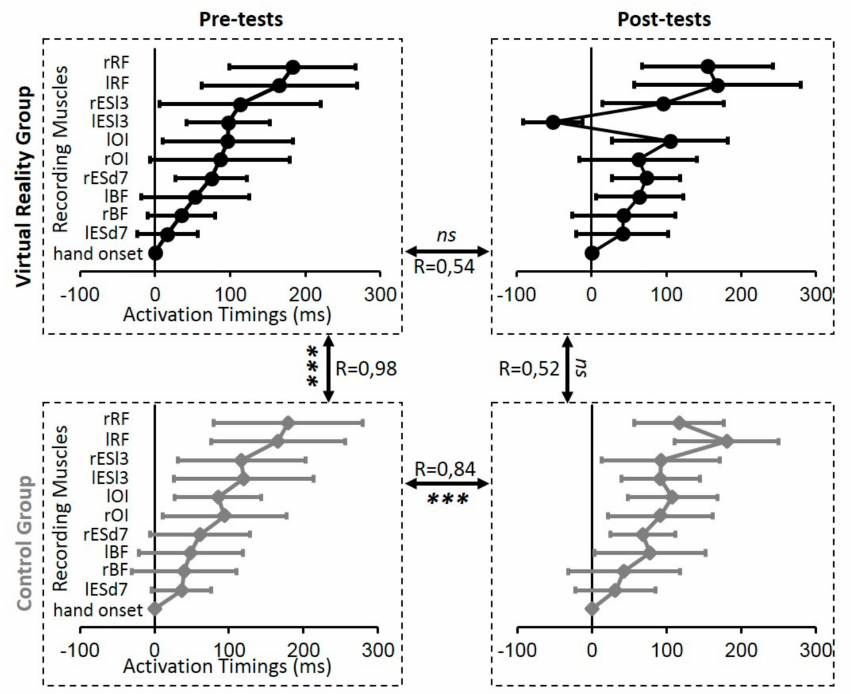
Figure 5. Whole sequences of averaged ( ± standard deviation) muscular activation timings (in milliseconds) used to initiate the arm-raising movement in the pre- and post-test sessions (in column) for all participants in the VR (upper line) and the CTRL (bottom line) groups. Regarding the duration axis, the origin (0) corresponds to the hand movement onset. To compare these four global sequences of muscular activation timings, the correlation coefficient R between each pair of whole sequences was computed and reported here between the relevant pair of graphs. *** p <